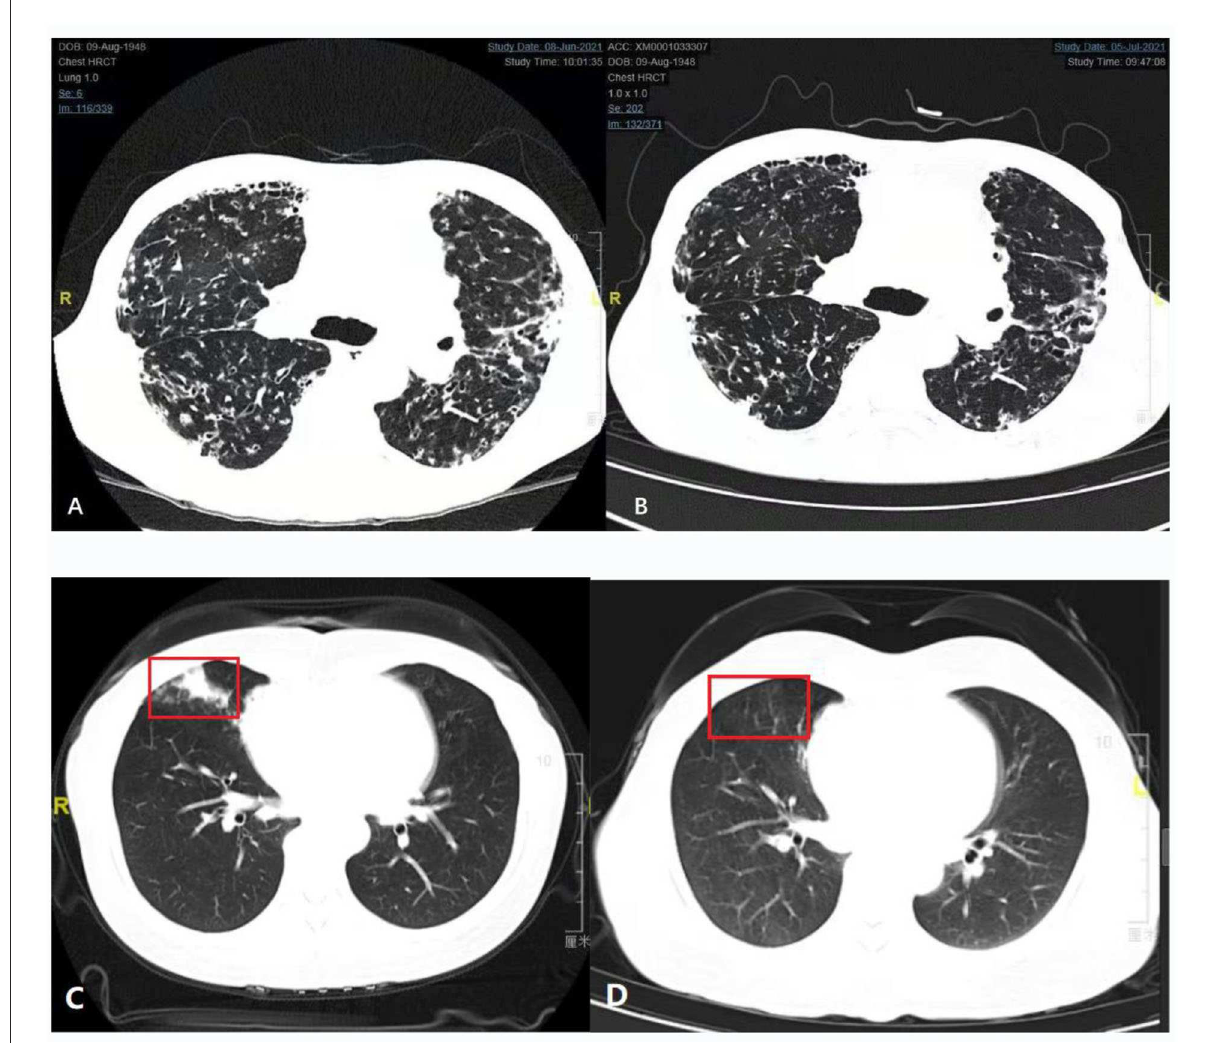
FIGURE2 Comparison of chest computed tomography (CT) before and after treatment (Case 16X and Case 17X). (A,B) Comparison of chest computed tomography (CT) before and after 4 weeks of antibiotic treatment (Case 16X). (A) Plain chest CT scan before antibiotic therapy. (B) Plain chest CT scan after 1 month of antibiotic therapy. (C,D) Comparison of chest CT before and after 3 months of antibiotic treatment (Case 17X). (C) Plain chest CT scan before antibiotic therapy. The red box is a typical Nocardia infection site. (D) Plain chest CT scan after 3 months of antibiotic therapy. Inflammation of the red box had